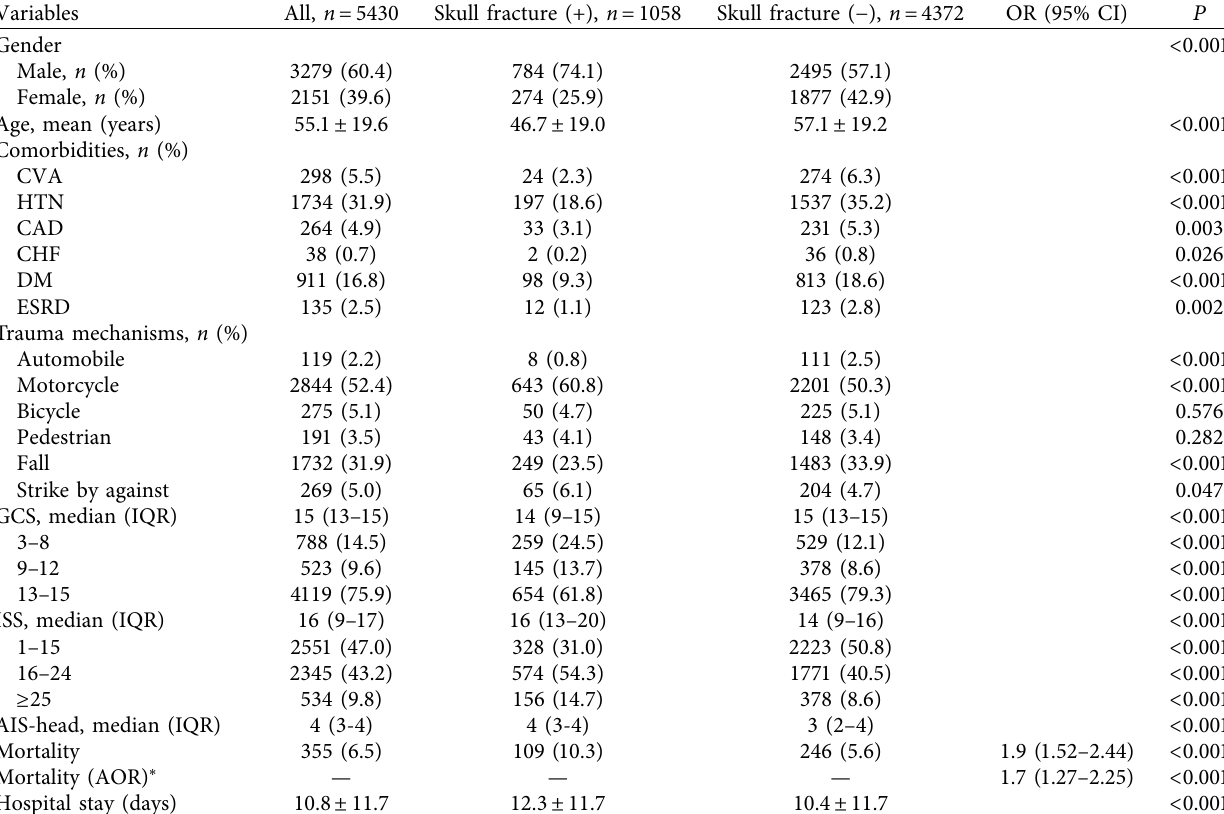
Table 1: The demographic traits and clinical characteristics of patients with traumatic brain